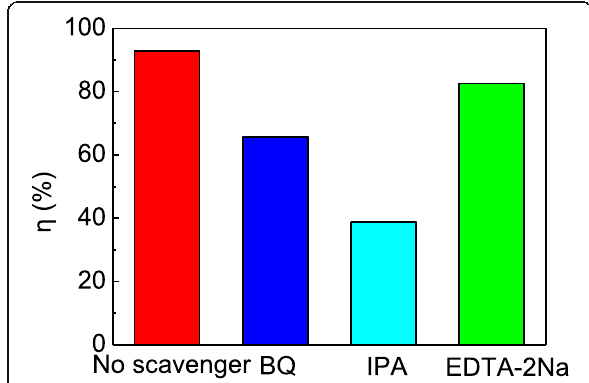
Fig. 8 The influence on degradation efficiency of RhB by Ag 3 PO 4 /T- ZnOw-2 with different scavengers (scavenger dose = 0.2 mmol/L)